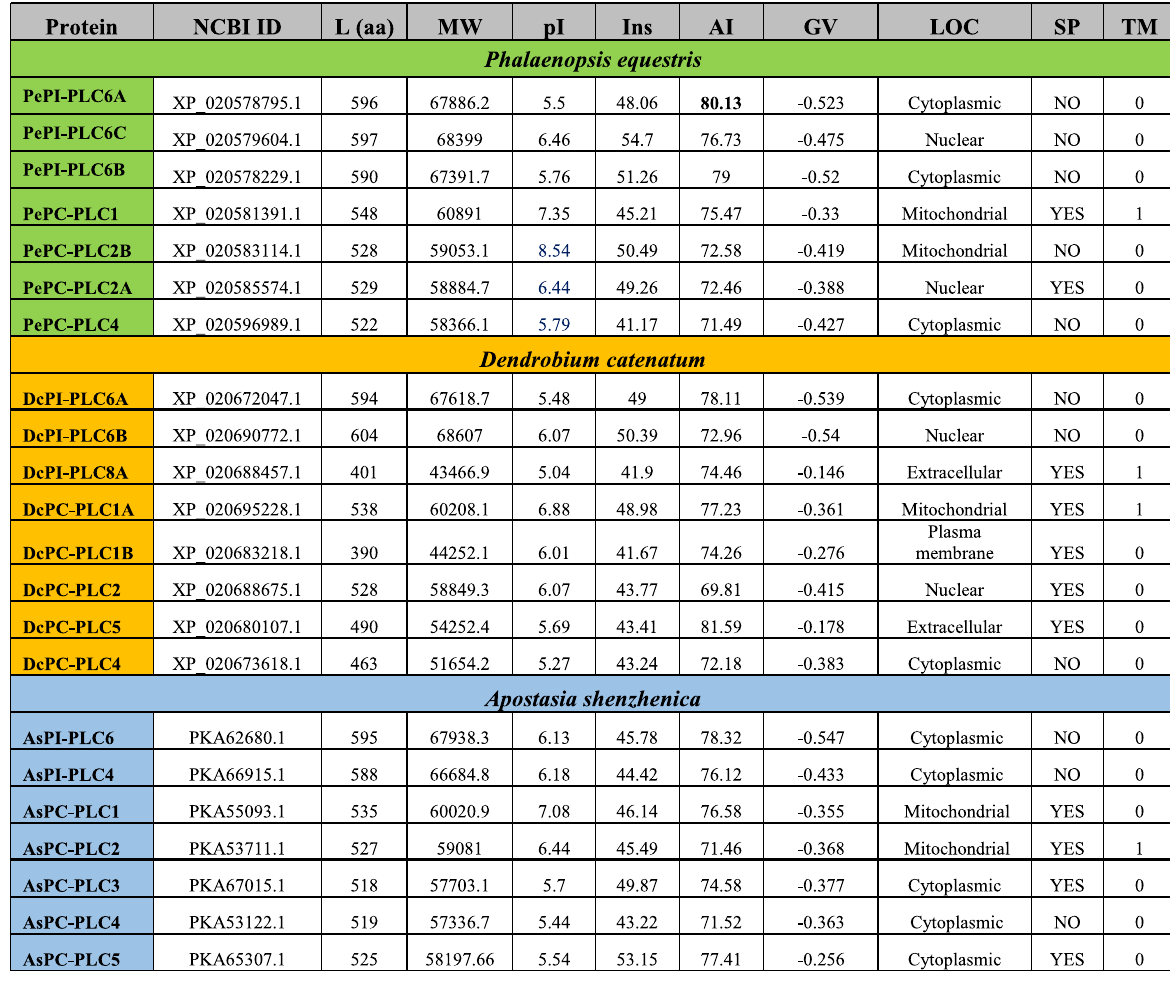
Table 2 Physiocochemical characterization of PePLC, DcPLC, and AsPLC